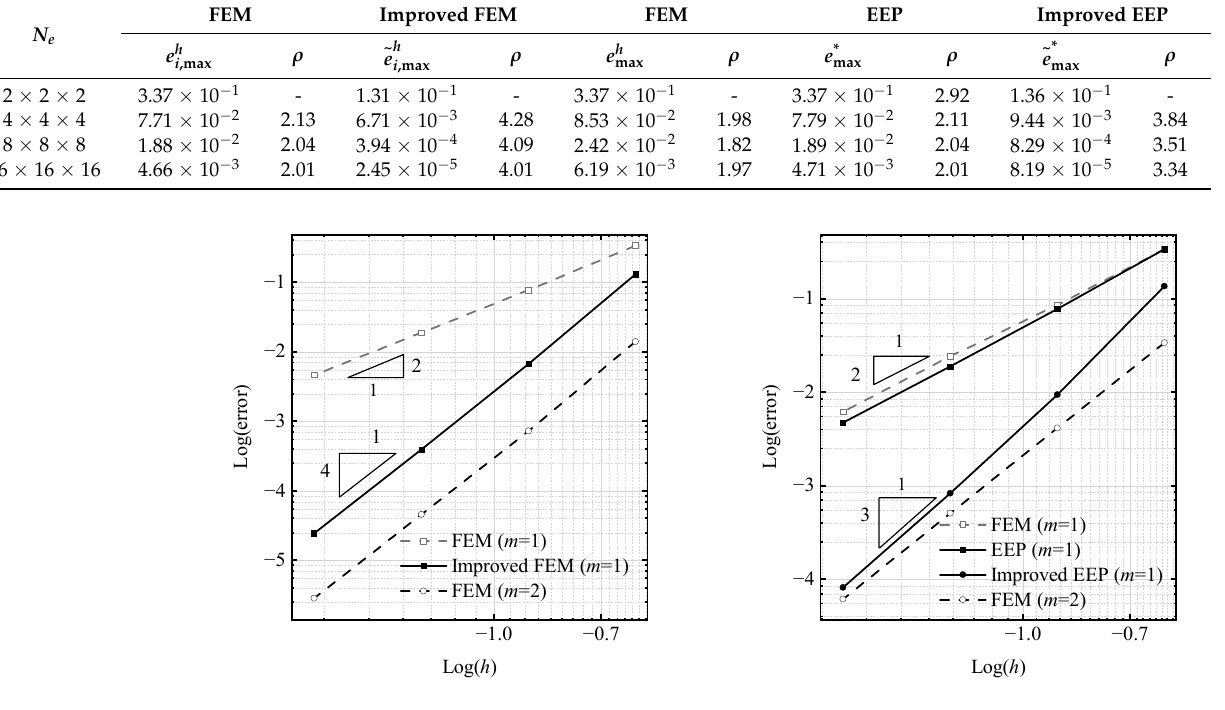
Figure 10. Convergence orders for: ( a ) nodal displacements; ( b ) interior displacements.